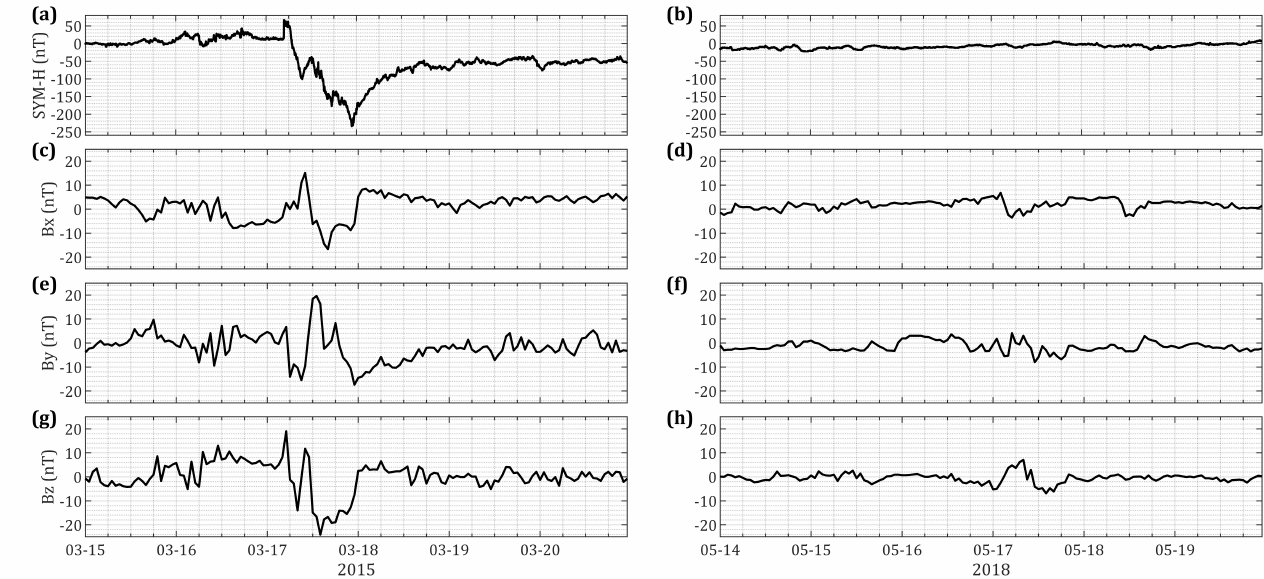
Figure 3. Geomagnetic records of ( a , b ) SYM-H indices, ( c , d ) IMF B x , ( e , f ) IMF B y and ( g , h ) IMF B z during 14–20 March 2015 and 14–19 May 2018. Unit: nano-Tesla